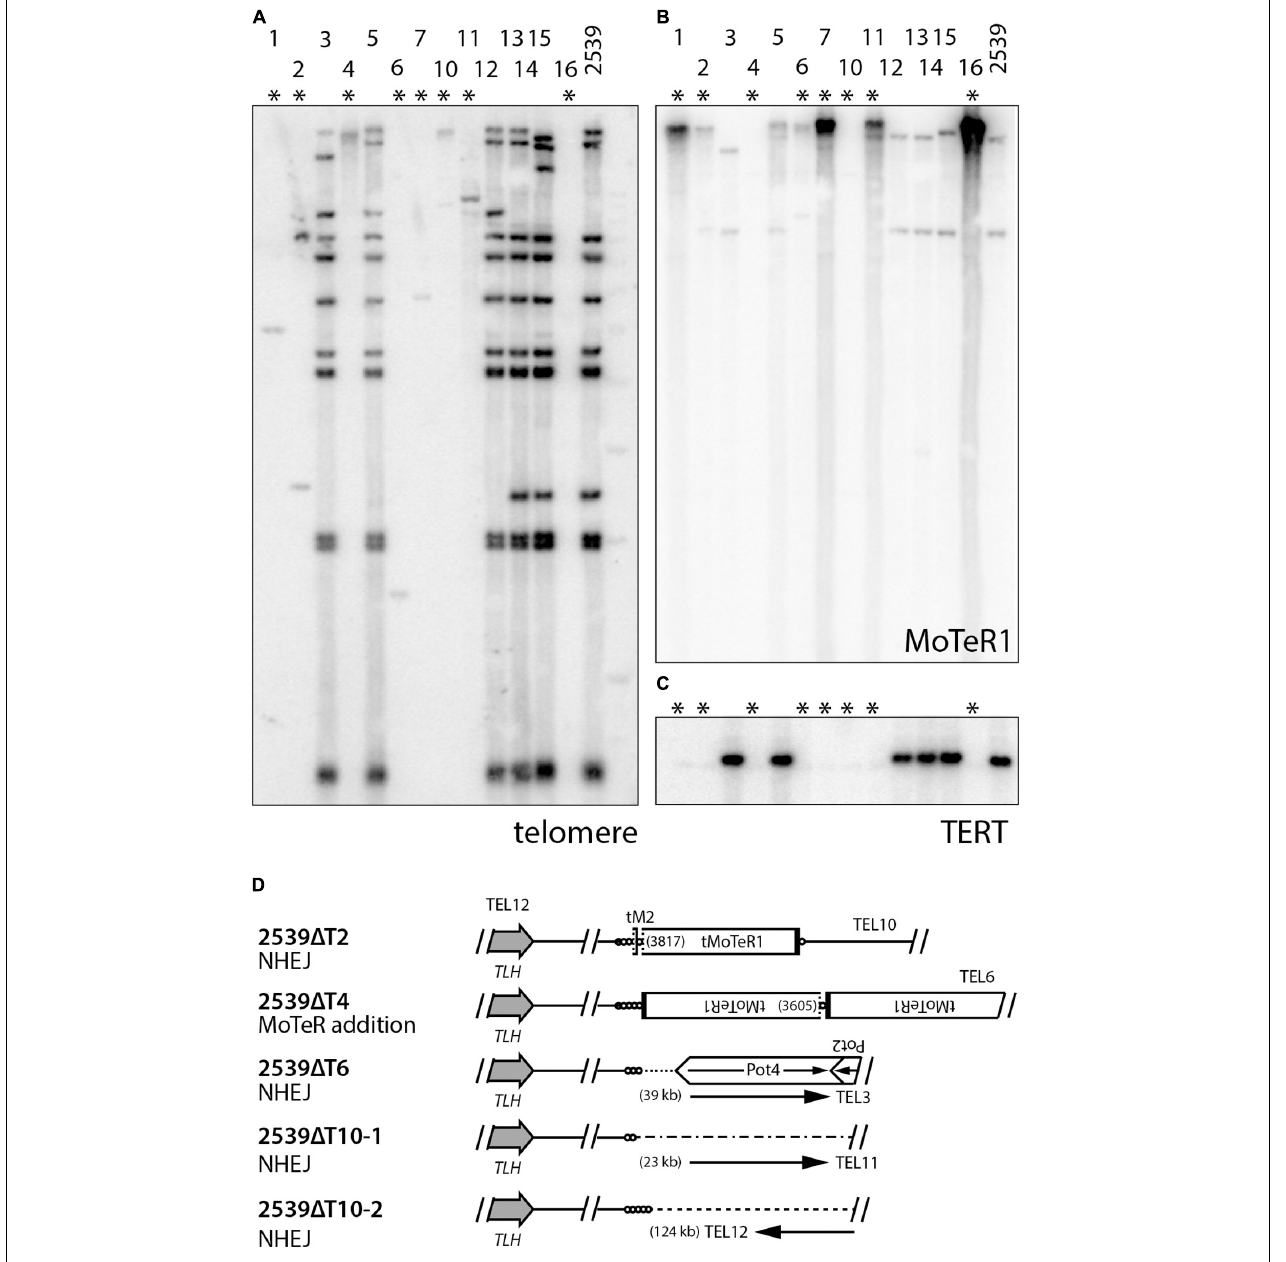
FIGURE 6 | Alternative telomere maintenance (ATM) in telomerase knockout (TERT KO) mutants of strain 2539. DNA was extracted from candidate telomerase knockout strains, digested with Pst I, size-fractionated by gel electrophoresis, and blotted to a membrane. Shown are phosphorimages obtained after sequential hybridization with probes for panels (A) telomere repeats, (B) MoTeR1, and (C) TERT. (D) shows repair mechanisms for telomere 12 in select TERT KO strains. TLH = telomere-linked helicase gene; circles = telomere repeats (lengths not to scale); MoTeR = M. oryzae telomeric retrotransposon; tMoTeR = truncated element with dotted line showing truncation boundary and parentheses listing truncation positions; Pot2/4 = inverted repeat transposon; arrows show direction to nearest telomere and distances to telomere are listed in